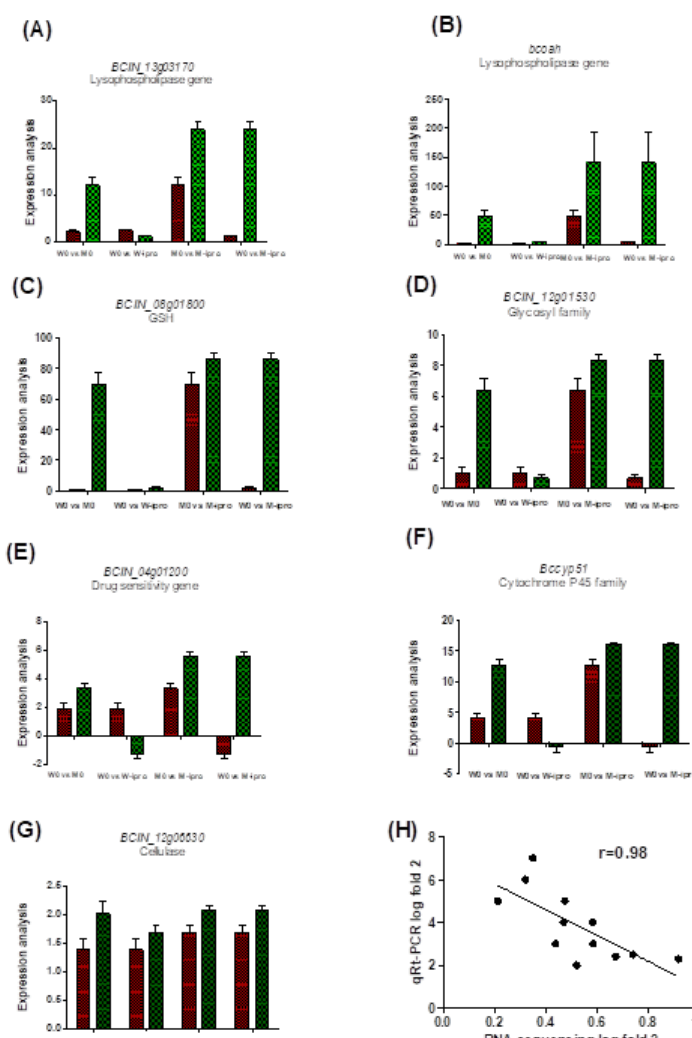
Figure 7. Validation of seven DEG’s log fold 2 value of RNA seq by qRT-PCR of wild type and its corresponding mutant with or without iprodione treatment. ( A,B ) lysopholipase genes, ( C ) Glutathione-S transferase gene, ( D ) Glycosyl family carbohydrate metabolism, ( E ) Drug sensitivity genes, ( F ) Cytochrome P450 family, ( G ) Cellulase genes, ( H ) Pearson correlation of log fold 2 value of qRT-PCR and RNA sequencing of wild type and its mutant after iprodione application. The mRNA abundance was normalized by using the reference gene UBQ and relative expression (log fold 2) was valued as 2 − ∆∆ CT . All values of qRT-PCR represents as mean ± SD ( n = 7).